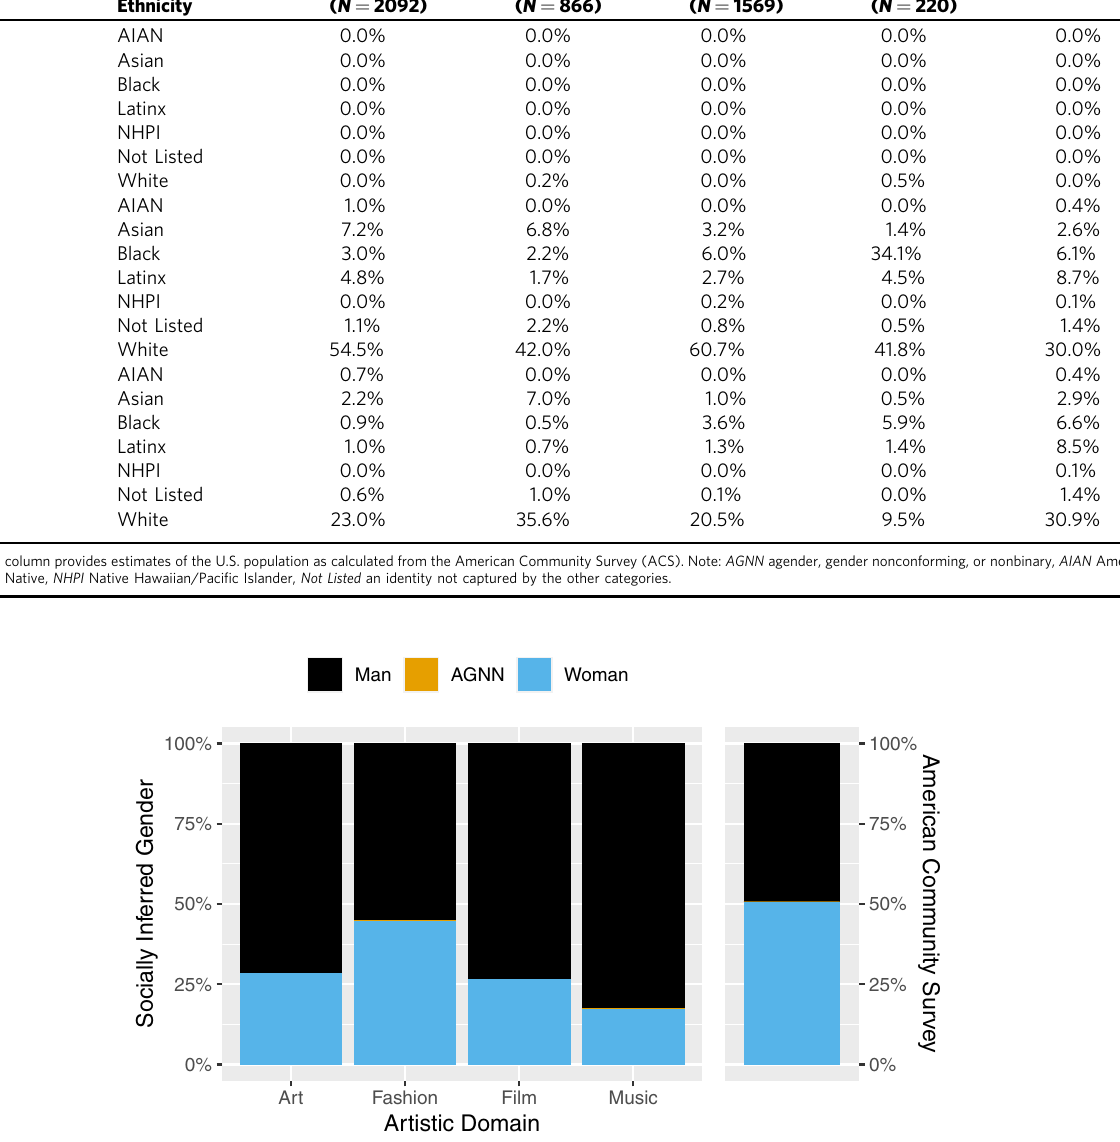
Fig. 1 Socially inferred gender across four creative domains and sex data from the American Community Survey (ACS) (U.S. Census Bureau, 2019). As compared to the ACS, women are underrepresented in each domain. Note: AGNN agender, gender nonconforming, or nonbinary. See Table 1 for numerical